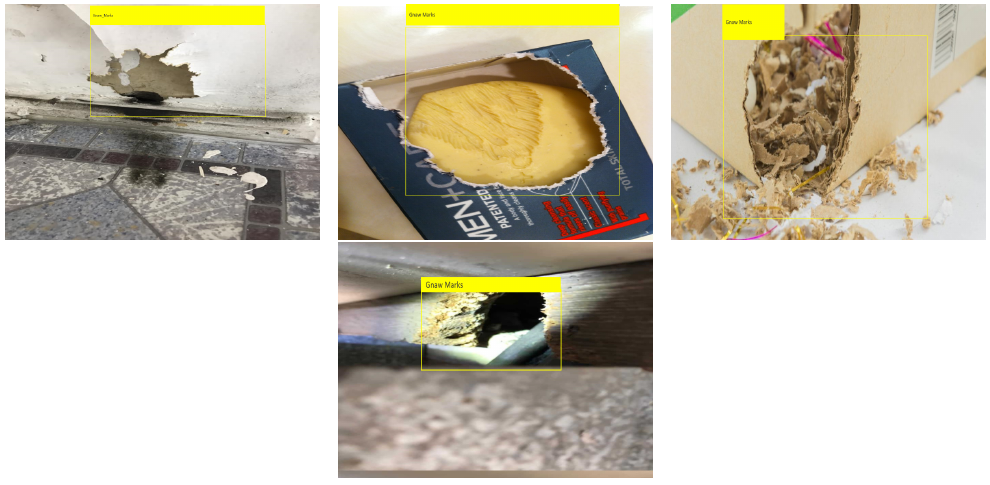
Figure 15. Gnaw marks detection